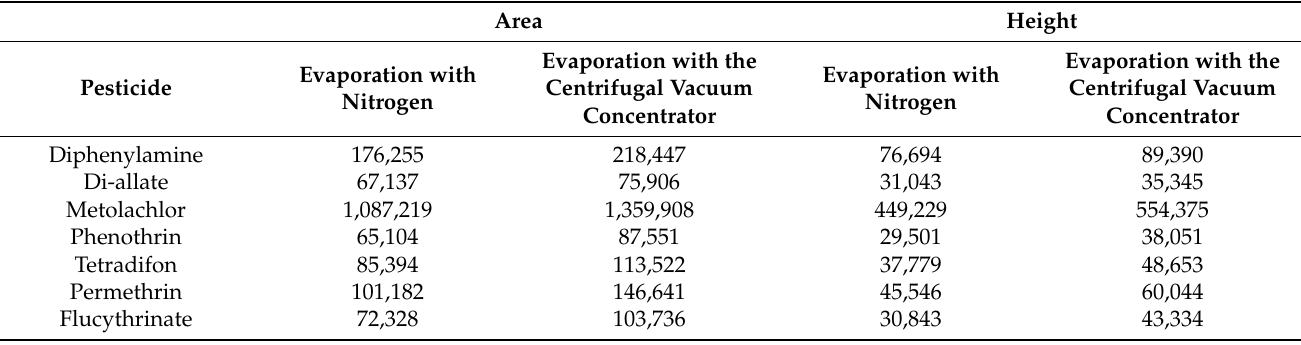
Table 2. Comparison of Peak Area and Height values of specific pesticides with the two different means of evaporation